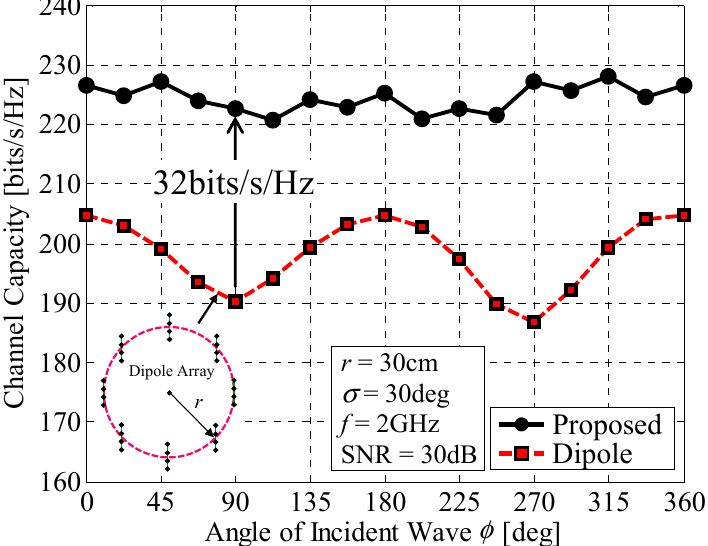
Figure 14. Channel capacity as a function of the angle of the incident wave.